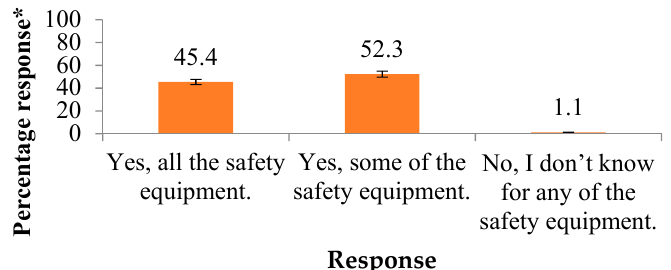
Figure 6. Percentage distribution of students’ response for the questions on Emergency Equipment